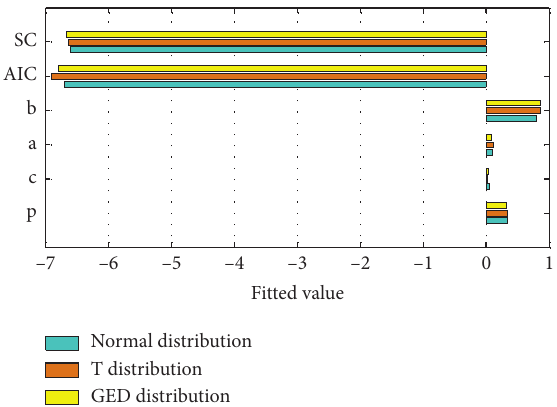
Figure 11: The result of the hypothetical parameter results of the sequence distribution of supply chain financial inventory portfolio price changes.